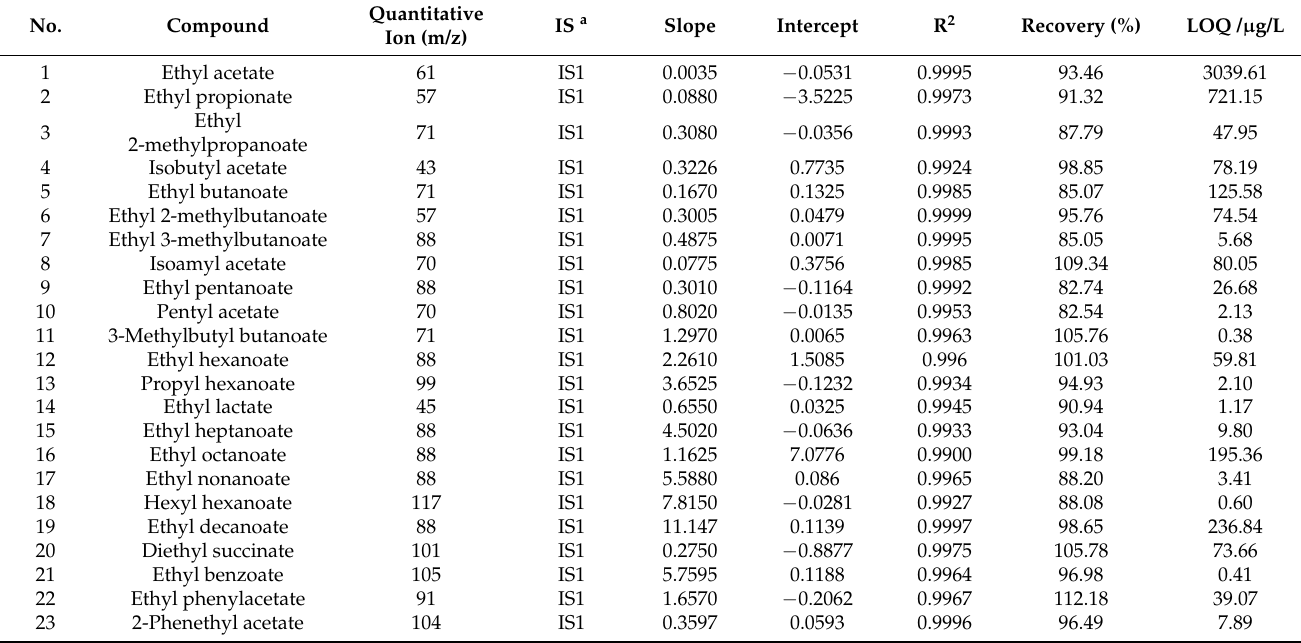
Table 2. Quantitative methodological parameters of aroma compounds in Chinese xiaoqu